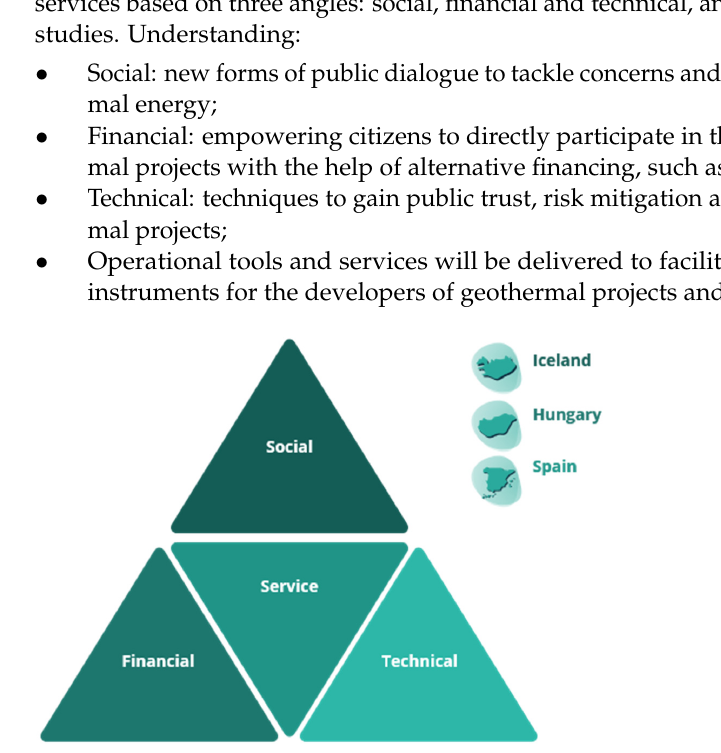
Figure 2. Schematic development of CROWDTHERMAL core services.